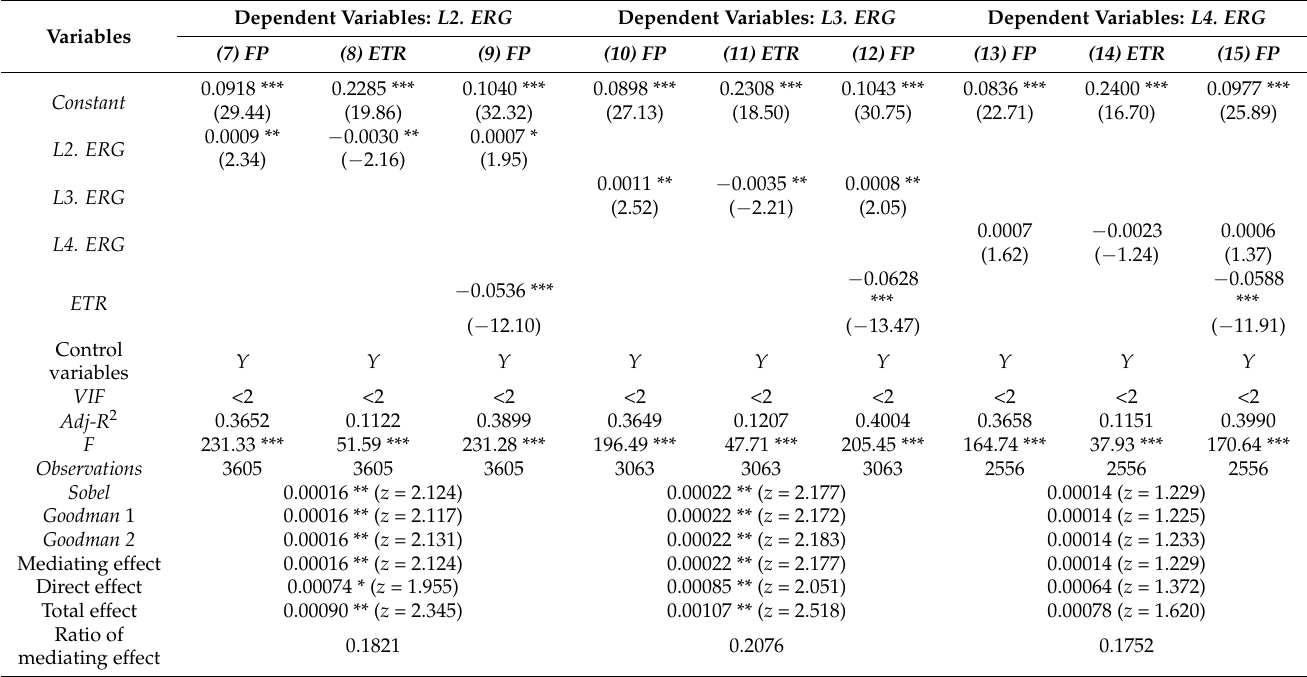
Table 6. Regression results (lag phase II, III and